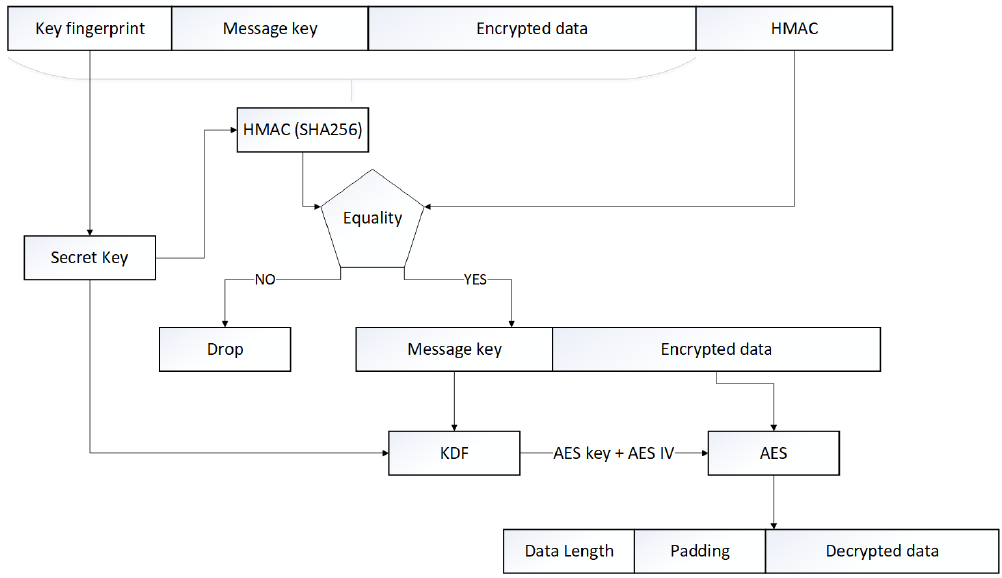
Figure 6. The decryption